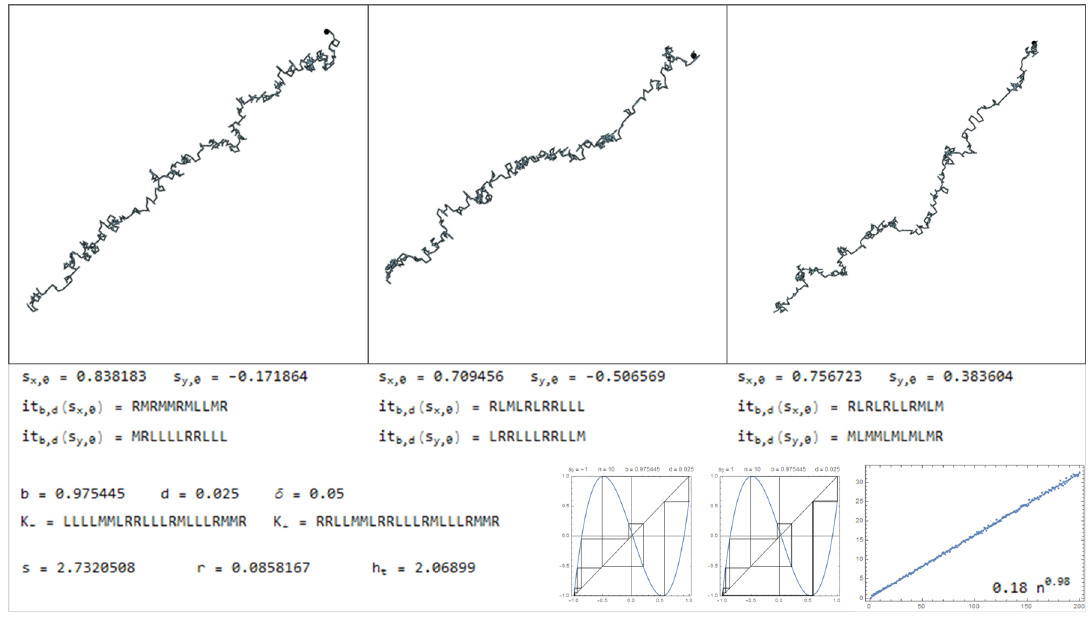
Figure 24. Trajectories produced with b = 0.975445 . . . and d = 0.025.